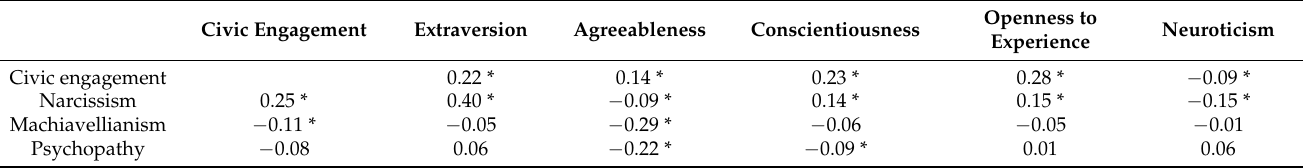
Table 2. Bivariate Correlations Among Study